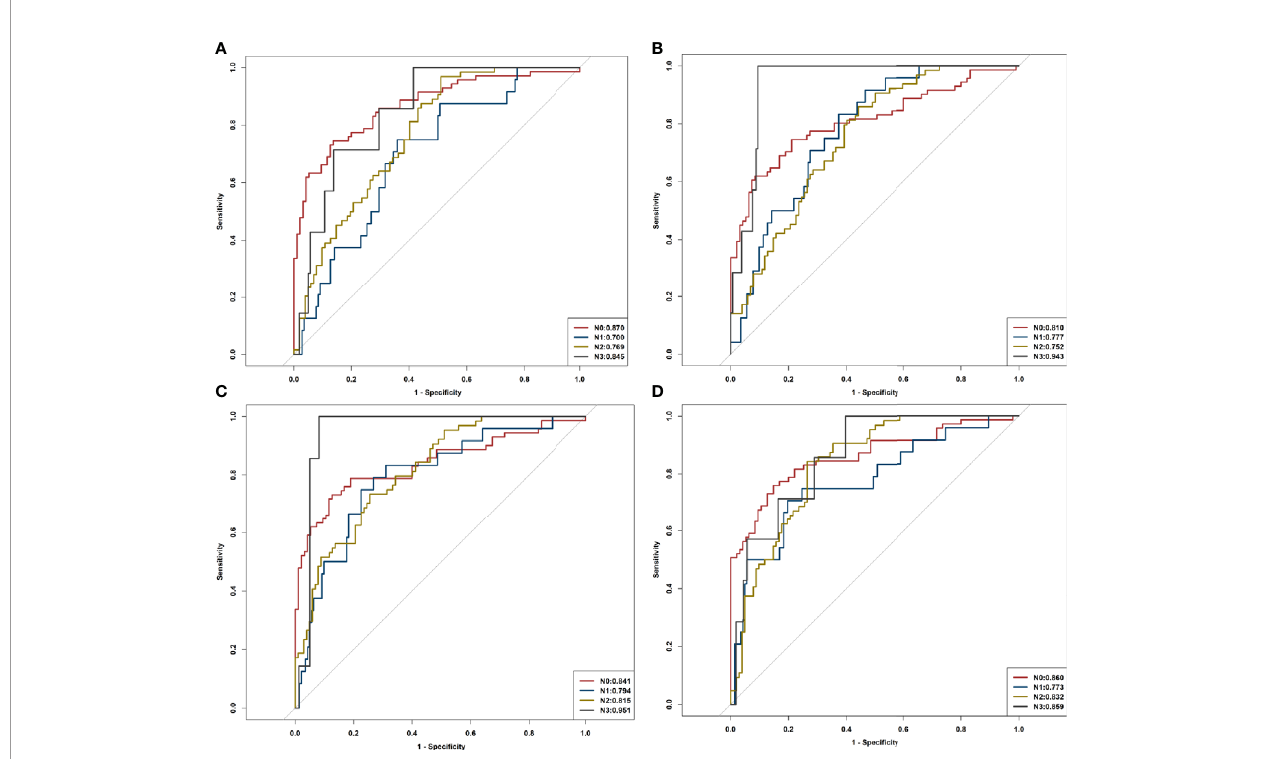
FIGURE 7 | ROC curves of R1, R2, R1+R2, and the combined model in identifying N0, N1, N2, and N3. (A) ROC curves of R1. (B) ROC curves of R2. (C) ROC curves of R1+R2. (D) ROC curves of the combined